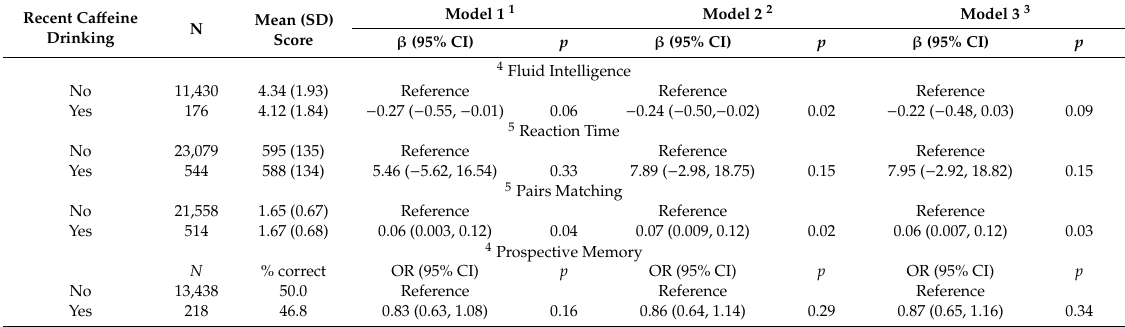
Table 3. Associationsbetweenrecentcaffeinedrinkingandcognitivefunctiontestsamongnon-whiteparticipants. Recent Ca ff eine Drinking